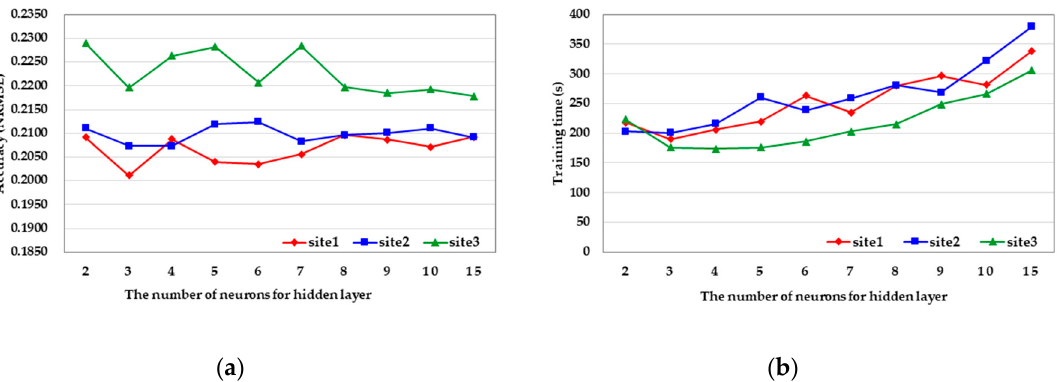
Figure 5. Experiments regarding the number of neurons for the hidden layer: ( a ) accuracy by setting different neurons, ( b ) training time by setting different neurons.